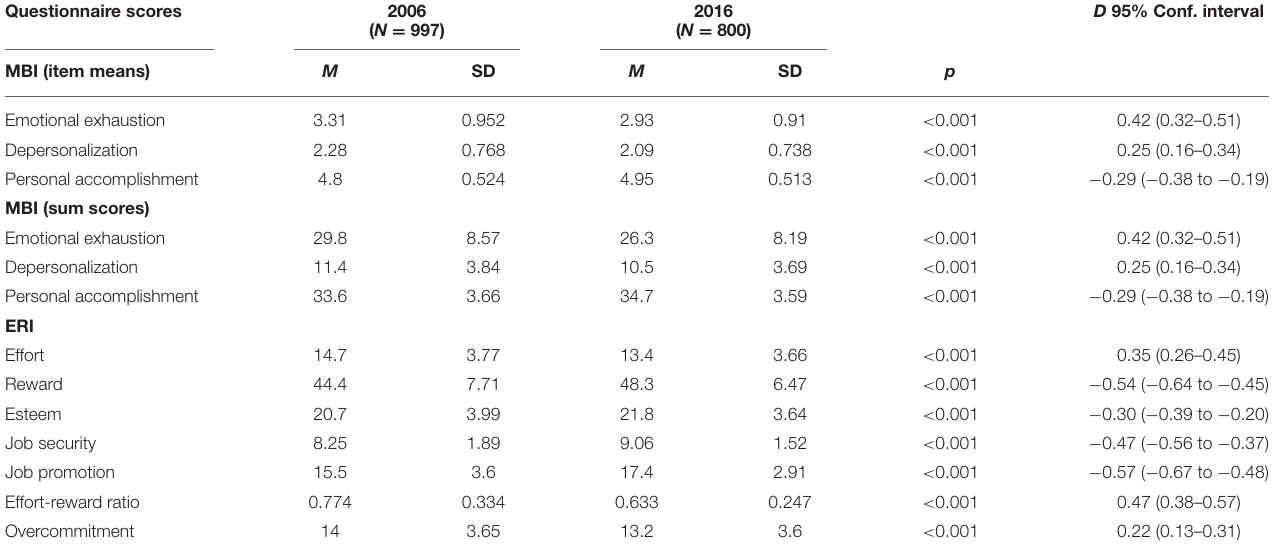
TABLE 3A | Comparison of questionnaire scores of the study samples in 2006 and 2016. Questionnaire scores